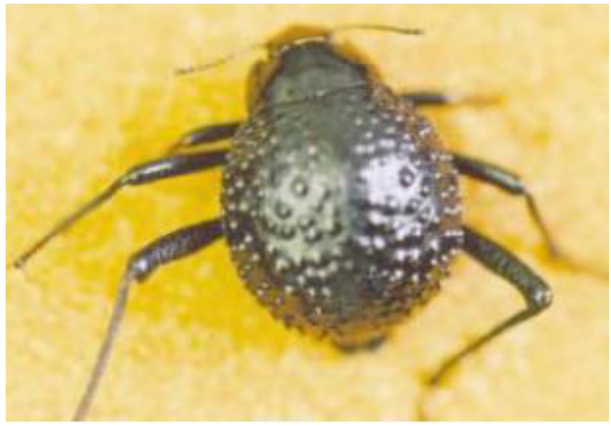
Figure 1: The Stenocara gracilipes. The beetle inspired the research of hybrid surfaces. The beetle inhabits the Namib desert, and it depends on fog to generate its water